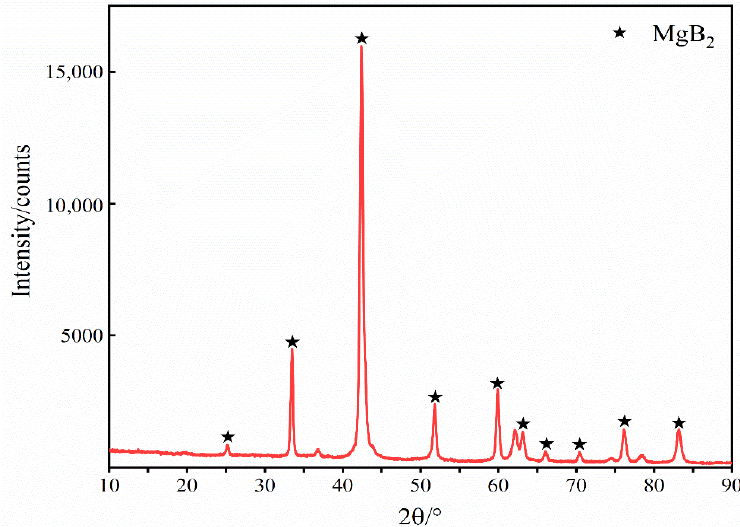
Figure 3. Comparison of the XRD patterns of prepared MgB 2 and PDF Card. The position of the spectrum peak and the corresponding intensity are consistent with the standard spectrum peak in the PDF card, and there is basically no spurious peak, indicating that the product is MgB 2 with high purity.